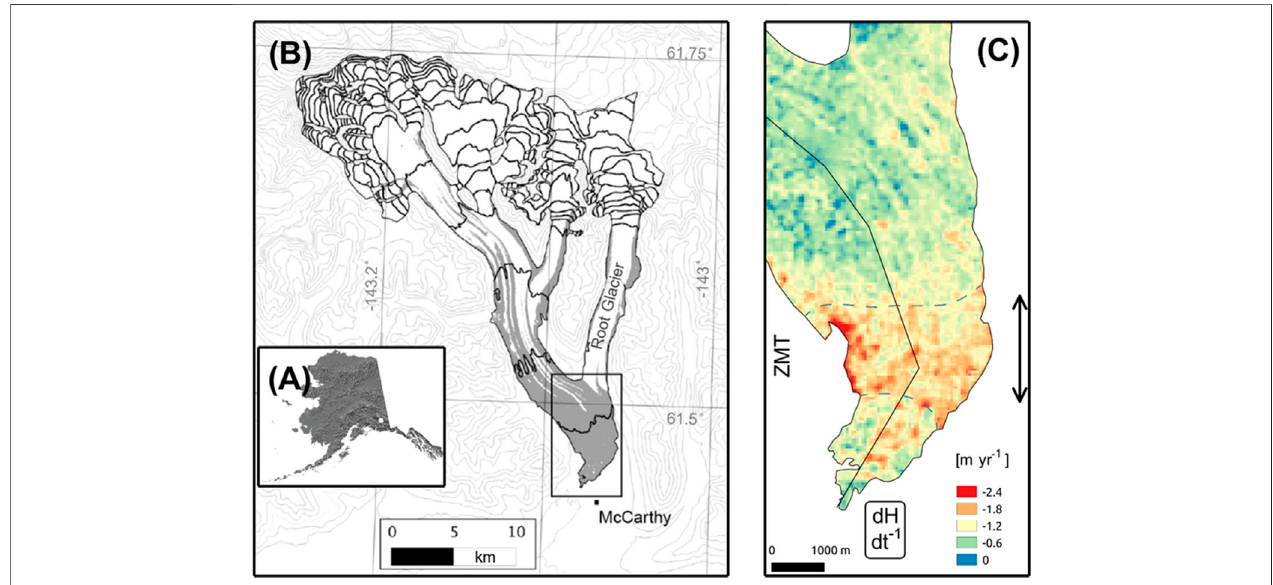
FIGURE1| Contextandthinningmapsofthestudyarea. (A) MapofAlaskashowingthelocationofpanelBasawhitesquare. (B) KennicottGlacierwiththeextent ofpanelCasablackrectangle.Thecontourintervalis200 m.Themostsoutherlycontourontheglacierrepresents600 ma.s.l. (C) Thestudyareawiththerateofglacier surfaceelevationchange(dHdt − 1 )between1957and2004(seeDasetal.,2014). ZMT referstothezoneofmaximumthinninganditsextentisdesignatedbythedouble headedarrowandthebluedashedlinesontheglacier.Thesolidblacklineisthetraceofthe1,000 mwideswathpro fi leusedtopresentdatawithdistancefromthe terminus in later fi gures.